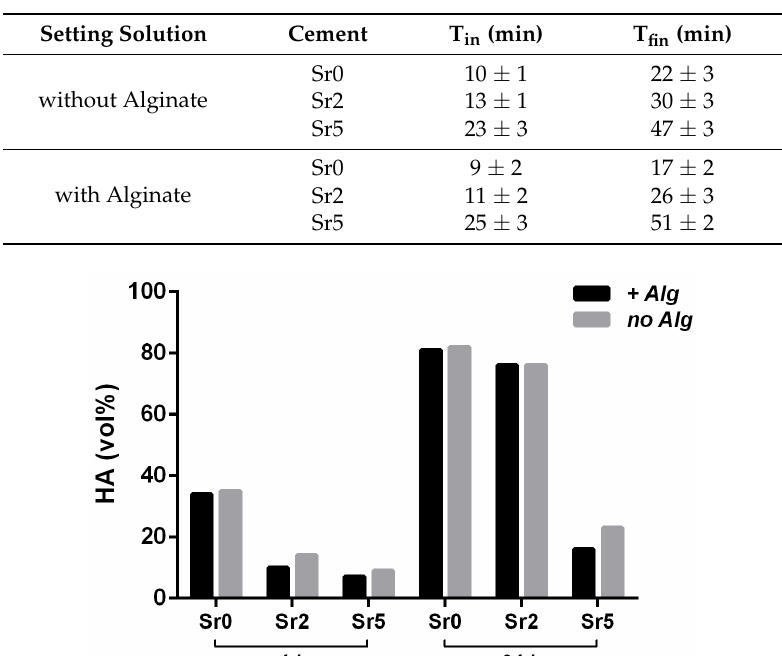
Figure 4. Progress of the transformation of α TCP precursors into HA over time, with and without alginate.